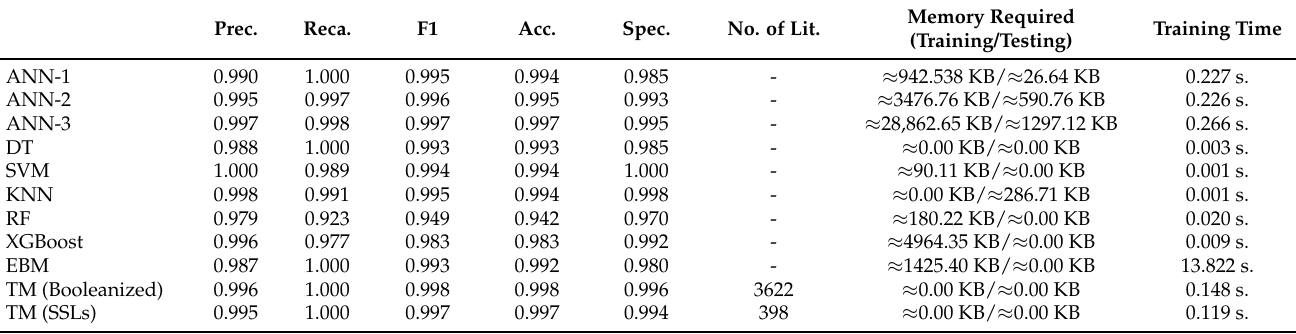
Table 10. Performance comparison for Bankruptcy dataset.